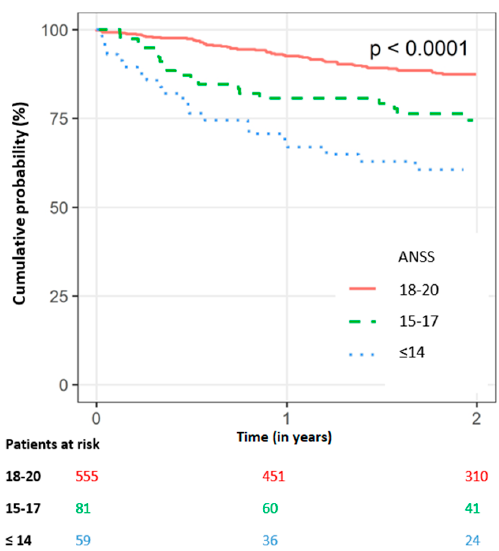
Figure 3. Kaplan–Meier survival curve for death without prior defibrillator therapy over time by admission Norton scale score (numbers reflect patients at risk. p value < 0.0001). (ANSS, Admission Norton scale score).